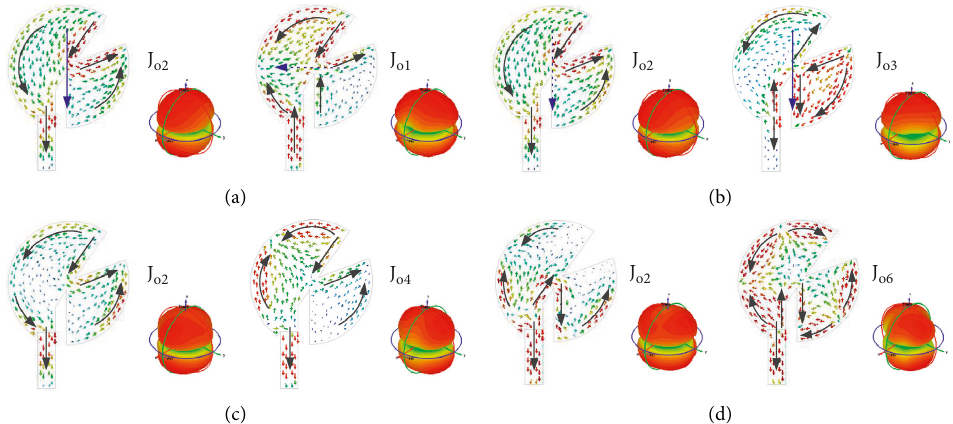
Figure 8: Modal currents and radiation patterns for the Proto A of (a) modes J Modes J o 2 and J o 4 at 6.1GHz. (d) Modes J o 2 and J o 6 at